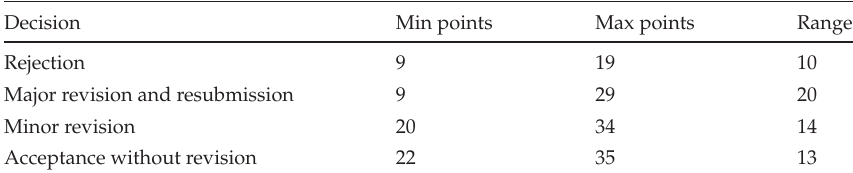
Table 18: Overlapping points and recommendations for PR1.